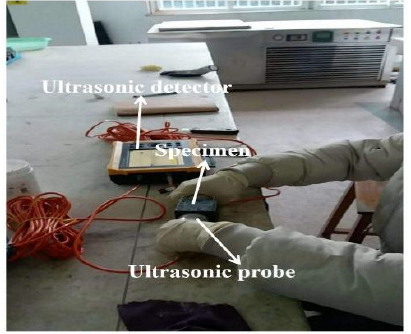
Figure 2. The ultrasonic velocity test